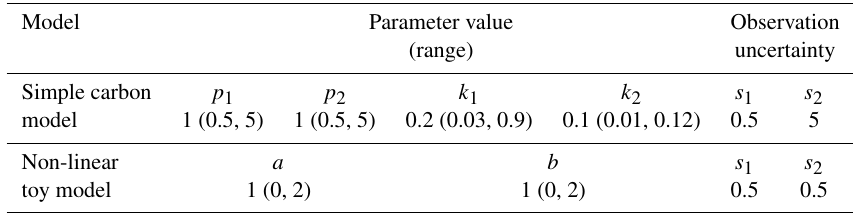
Table 1. The optimisation set-up for both models, including the true parameter values, their range and the observation uncertainty (1 σ ), which was set to 10% of the mean value for each set of pseudo-observations derived from multiple first guesses of the model. The parameter uncertainty (1 σ ) was set to 40% of the range for each parameter.